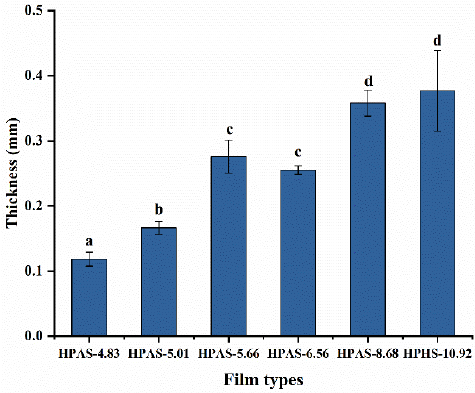
ff erent citric acid amount. Figure 3. Thickness of HPAS-CA films with different citric acid amount. Figure 3. Thickness of HPAS-CA films with different citric acid amount. Figure 3. Thickness of HPAS-CA films with di